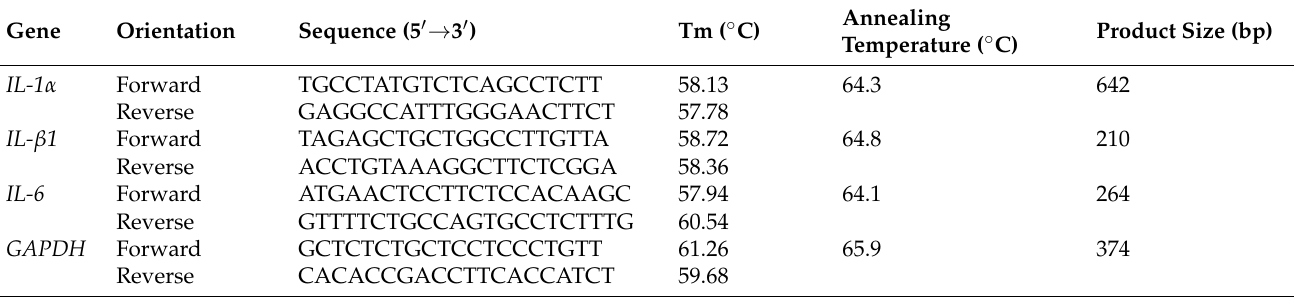
Table 1. Primer sequences and